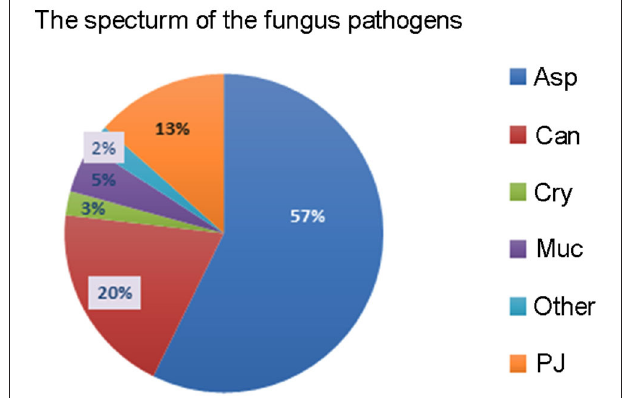
FIGURE 1 | The spectrum of fungal pathogens in lung transplant recipients with invasive fungal disease. Asp, Aspergillus ; Can, Candida ; Cry, Cryptococcus ; Muc, Mucorales ; PJ, Pneumocystis jiroveci